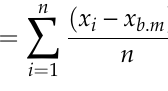
Figure 10. Micro-hardness profile in ( a ) depth and ( b ) width of the hardened laser layer (samples #7, #8, and #10); see Figure 2.